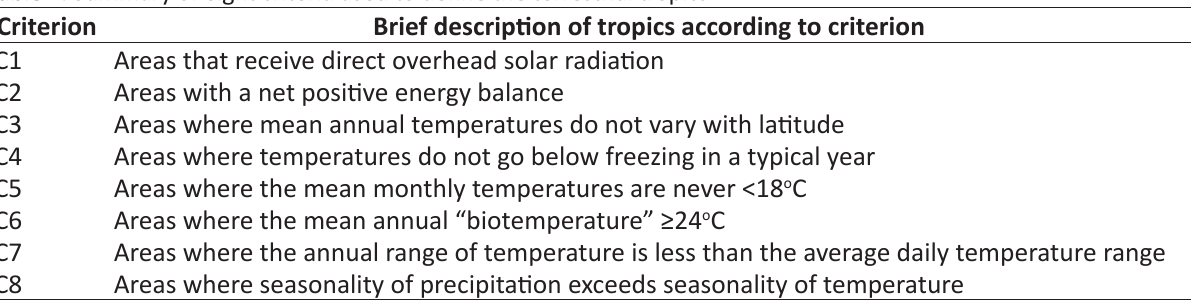
Table 1. Summary of eight criteria used to define the terrestrial tropics Criterion